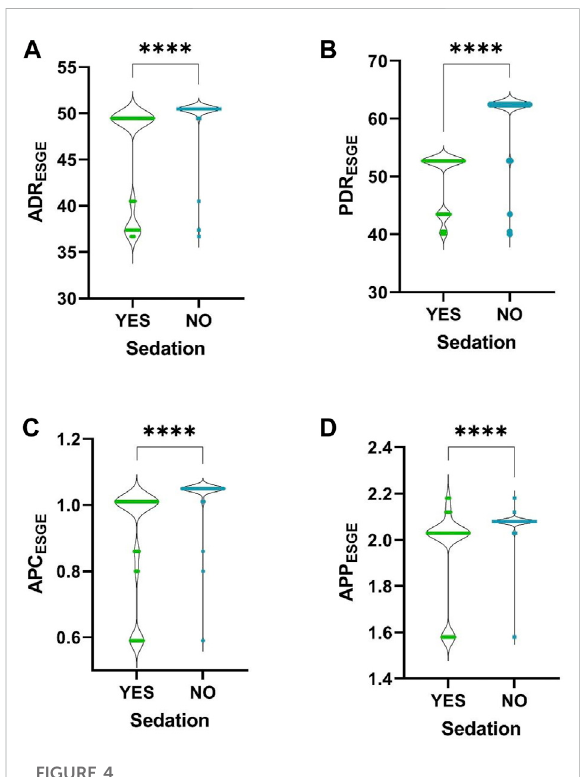
FIGURE 4 Comparison between male andfemalepatients. (A) ,ADR; (B) , PDR; (C) , APC; (D) , APP. ns, p- value >